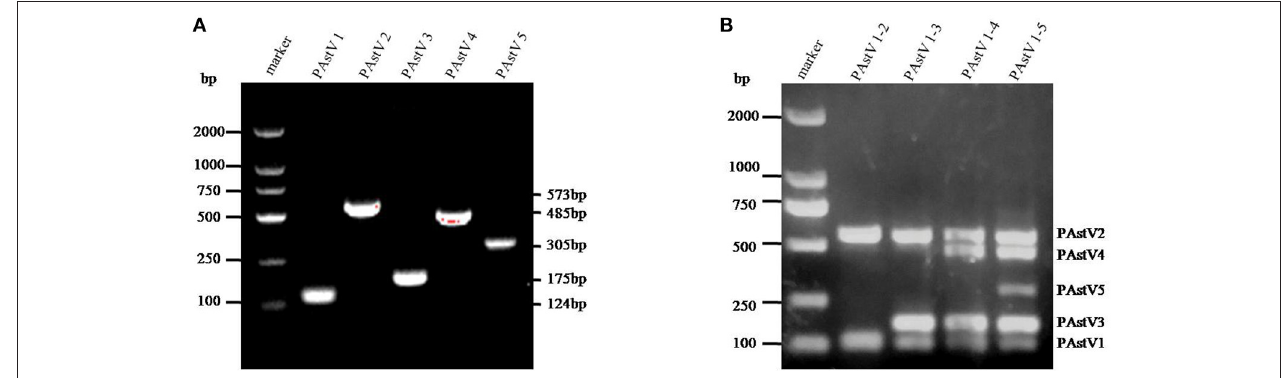
FIGURE 1 | The multiplex RT-PCR assay is well-established. (A) Total RNA was extracted from the clinical positive samples with TRIzol reagent and subjected to reverse transcription with hexamer random primer. The cDNAs were amplified with primers targeting genes of each genotype described in Table 1 . (B) Multiplex RT-PCR was developed for the detection of all these five known porcine astrovirus (PAstV) genotypes. The prepared standard plasmids and corresponding primer sets were added one by one, constituting duplex, triplex, quadruple, and quintuple PCR mixtures.